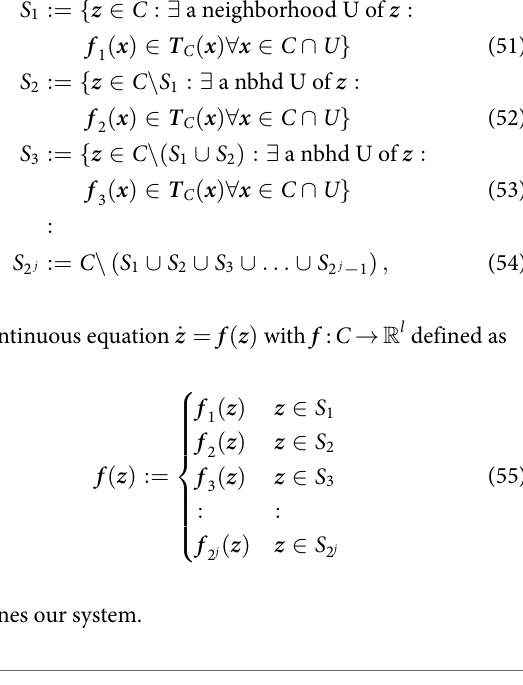
TABLE 1 | System equations for the resulting 2 j modes for j high-priority set-based tasks